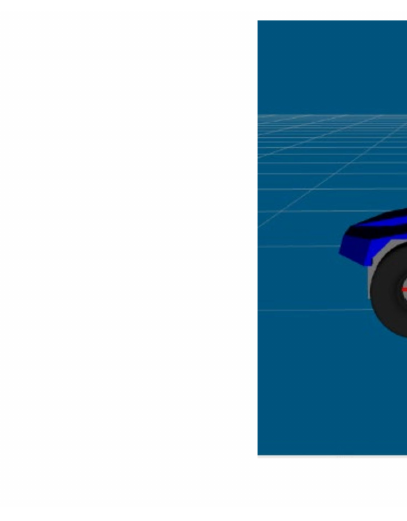
Figure 8. Robot models. ( a ) Front view of URDF model. ( b ) Side view of URDF